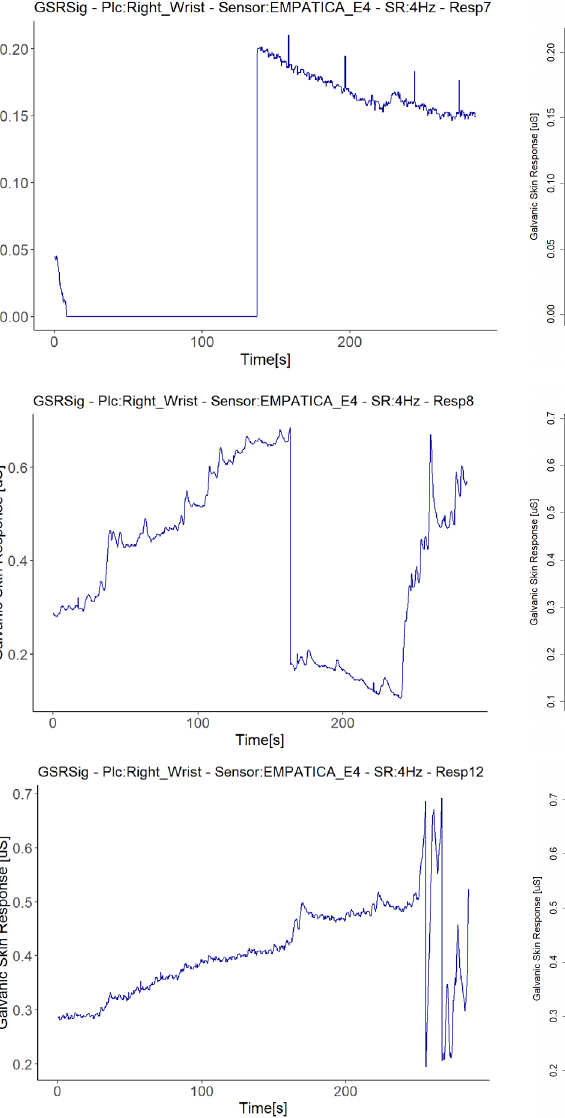
Figure 12. Illustration of cases of abrupt jump anomalies. On the left are the signals with the anomaly turned into a graph from the downsampled data; on the right are the other signals measured in the same respondent with the same type of sensor, turned into a graph from the raw data, zooming in on the time interval.